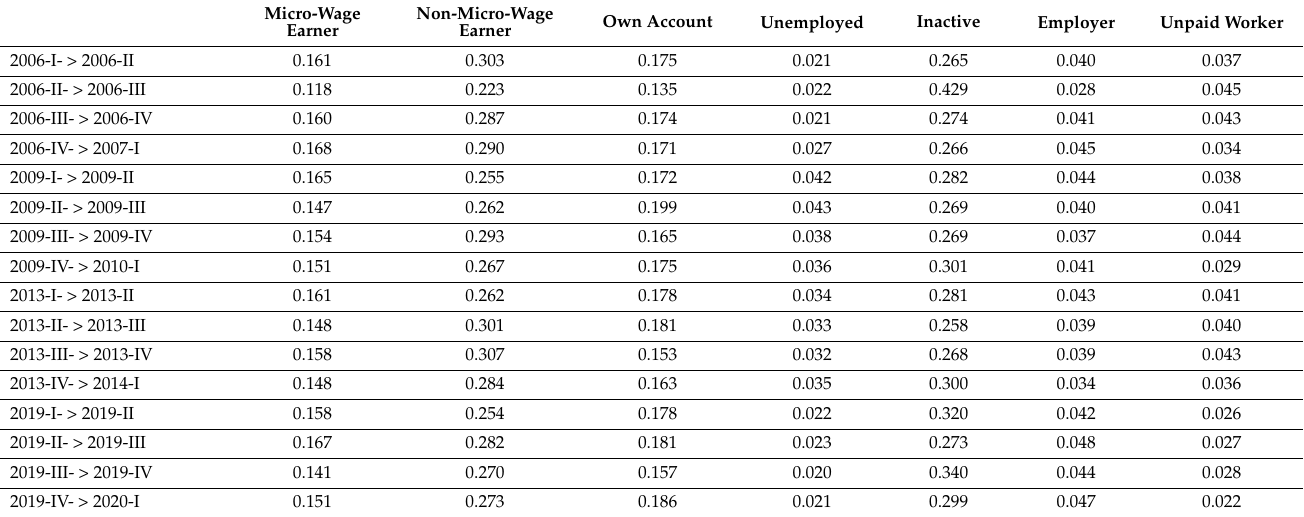
Table 5. Employment-transition steady states of men in